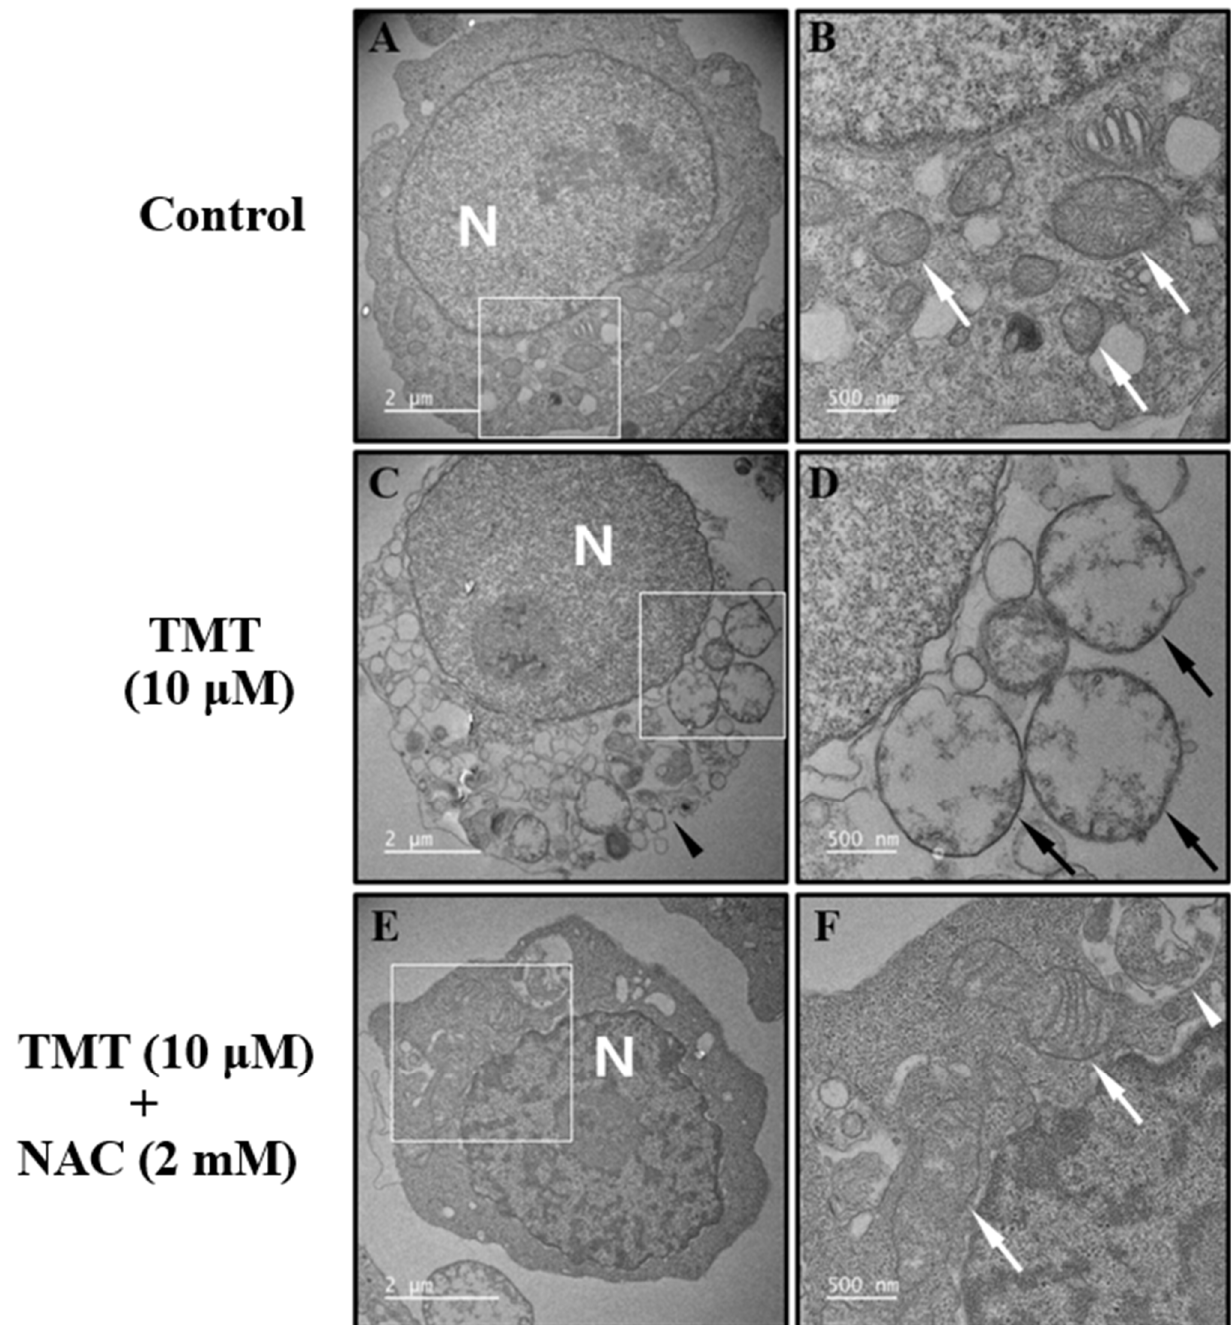
Figure 5. Transmission electron microscopy (TEM) images of SH-SY5Y cells treated with vehicle as control ( A , B ), 10- µ M TMT ( C , D ), and 10- µ M TMT + 2 mM NAC ( E , F ). ( B , D , F ) are magnified white-square portions of ( A , C , E ), respectively. The white arrow and pointer in ( B , F ) indicate normal mitochondria and autophagolysosome, respectively. The black arrow and pointer in ( C , D ) indicate swollen mitochondria and ruptured cytoplasmic membrane. N: nucleus.